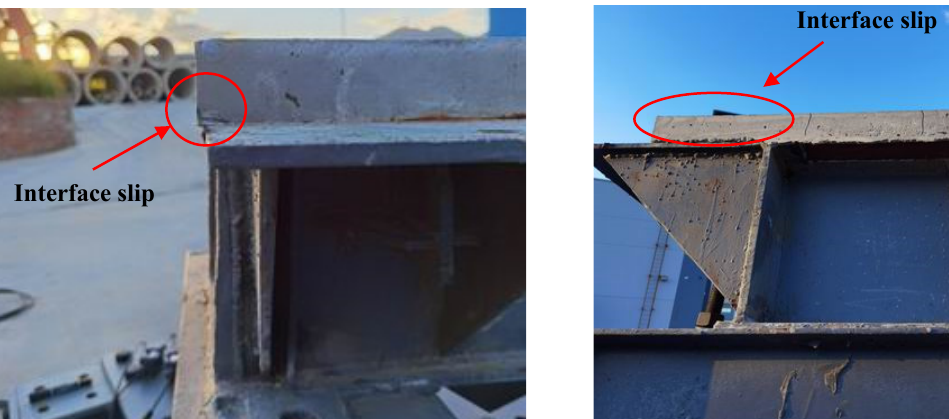
Figure 6. Test Figure 6. Test observations.